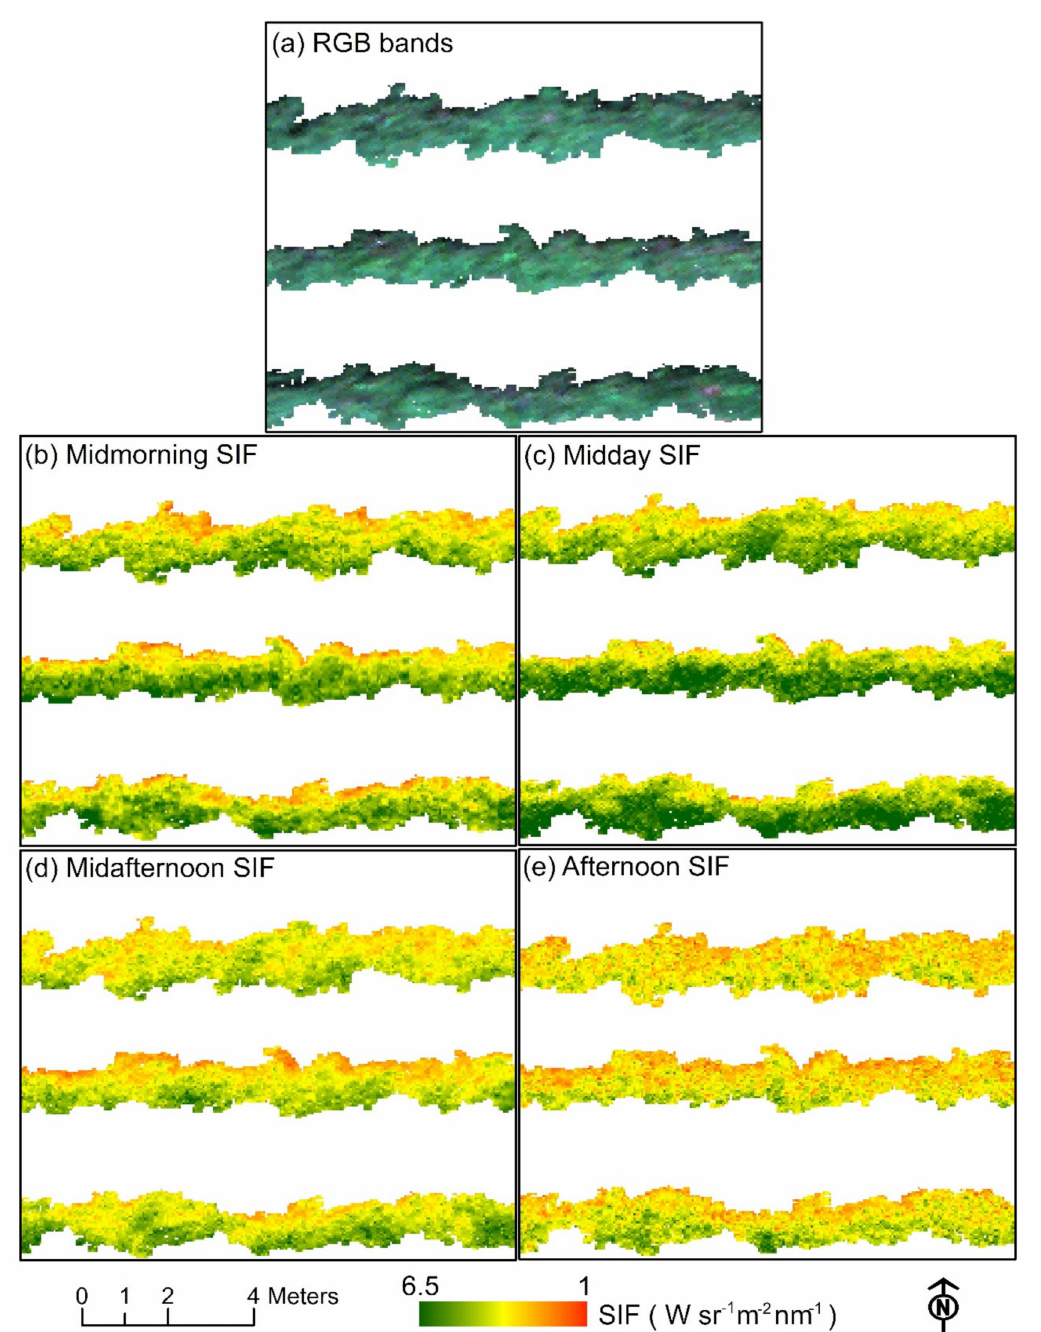
Figure 14. Diurnal SIF at the canopy level retrieved from the hyperspectral images acquired on 1 August 2018. ( a ) Zoom on three vine rows corresponding to three irrigation treatments, ( b – e ) zoom on vine rows showing SIF retrieval